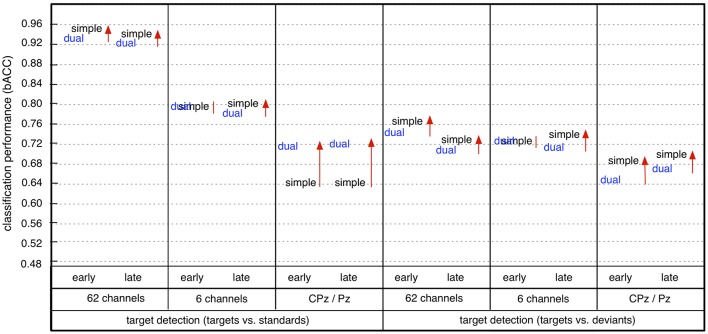
Effect of task condition on classification performance (early: early window, late: late window, simple: simple task, dual: dual task). Arrow direction refers to significant increases or decreases. Lines without arrow direction refer to no significant difference. Statistical values for comparison are reported in Supplementary Materials in Figure S5 (comparison between simple task (s) and dual task (d) in Figure S5).